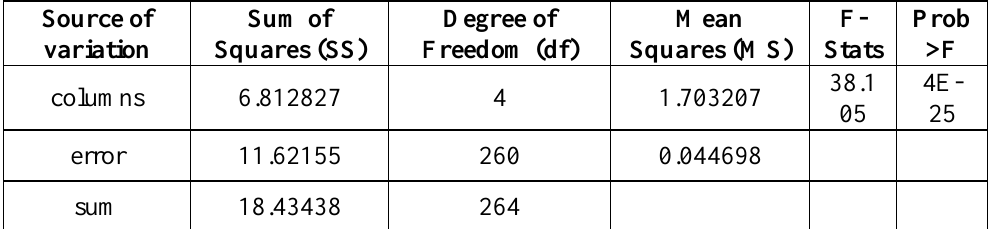
Table 8. One-Way Analysis of Variance for Beta Coefficient Variable